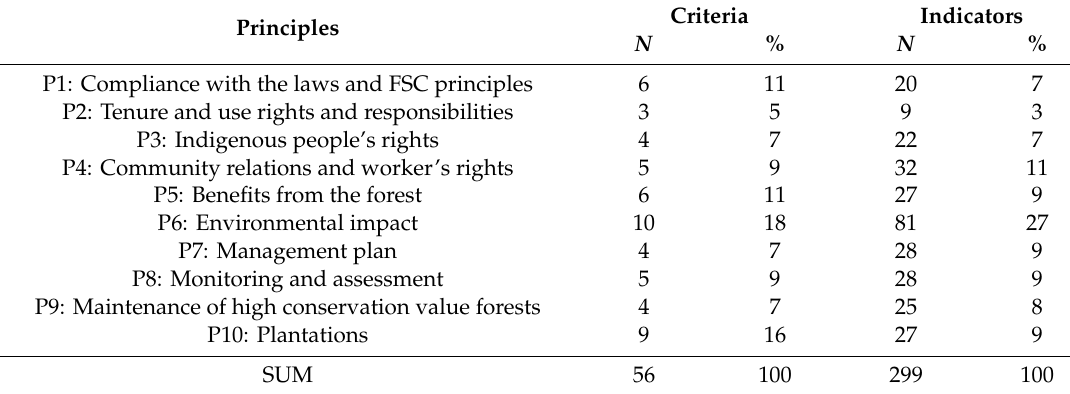
Table 1. Structure of Russian National Forest Management